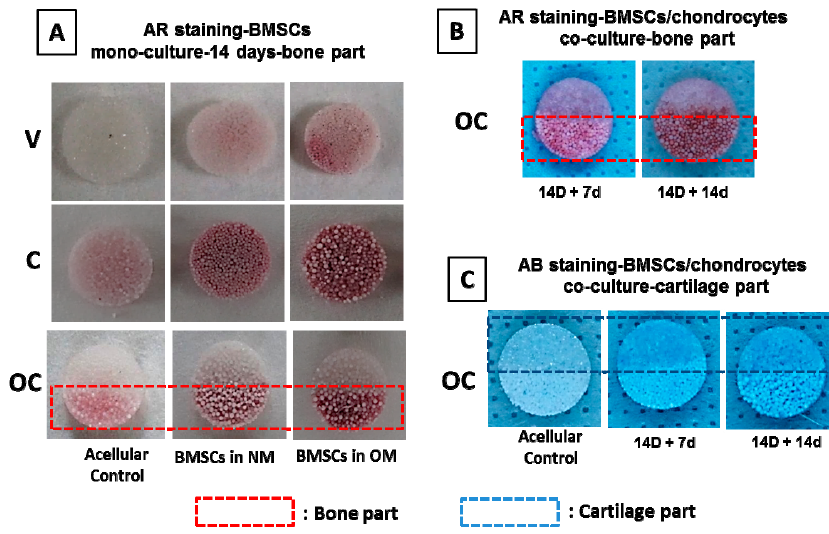
Figure 7. ( A ) The Alizarin red (AR) staining images of acellular control and BMSCs-seeded V, C, and OC scaffolds after mono-culture in normal medium (NM) and osteogenic medium (OM) for 14 days; ( B , C ) are the Alizarin red (AR) and Alcian blue (AB) staining images of BMSCs in the bone part and chondrocytes in the cartilage part of OC scaffolds. 14 D + 7 d and 14 D + 14 d denote the culture of BMSCs in the bone part of OC scaffolds in OM for 14 days followed by immersing in chondrocyte medium for another 7 and 14 days during co-culture.